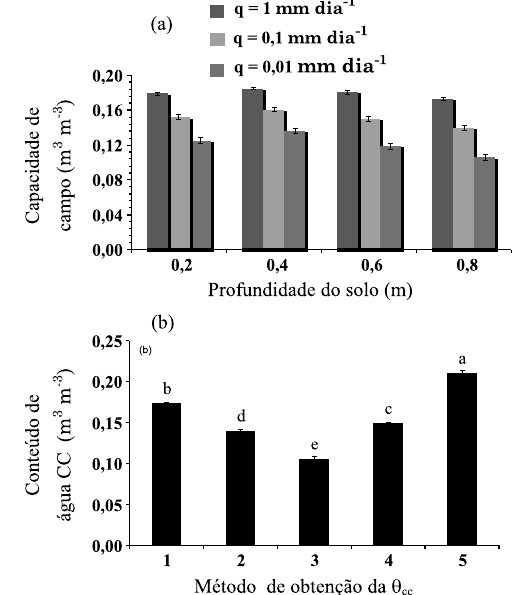
Figura 6. Capacidade de campo em função das